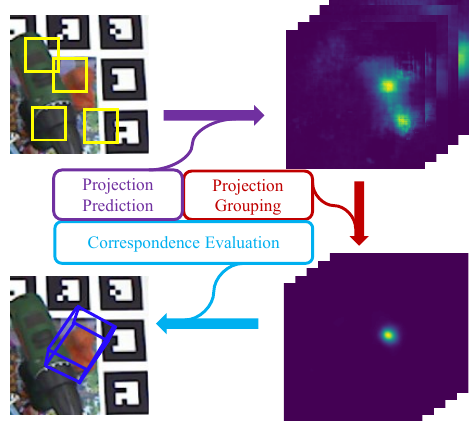
Figure 1. Overview of the proposed two-stage approach for recovering the 6D pose. For any input patch (yellow box), its corresponding output from projection prediction module consists of projection heatmaps with eight